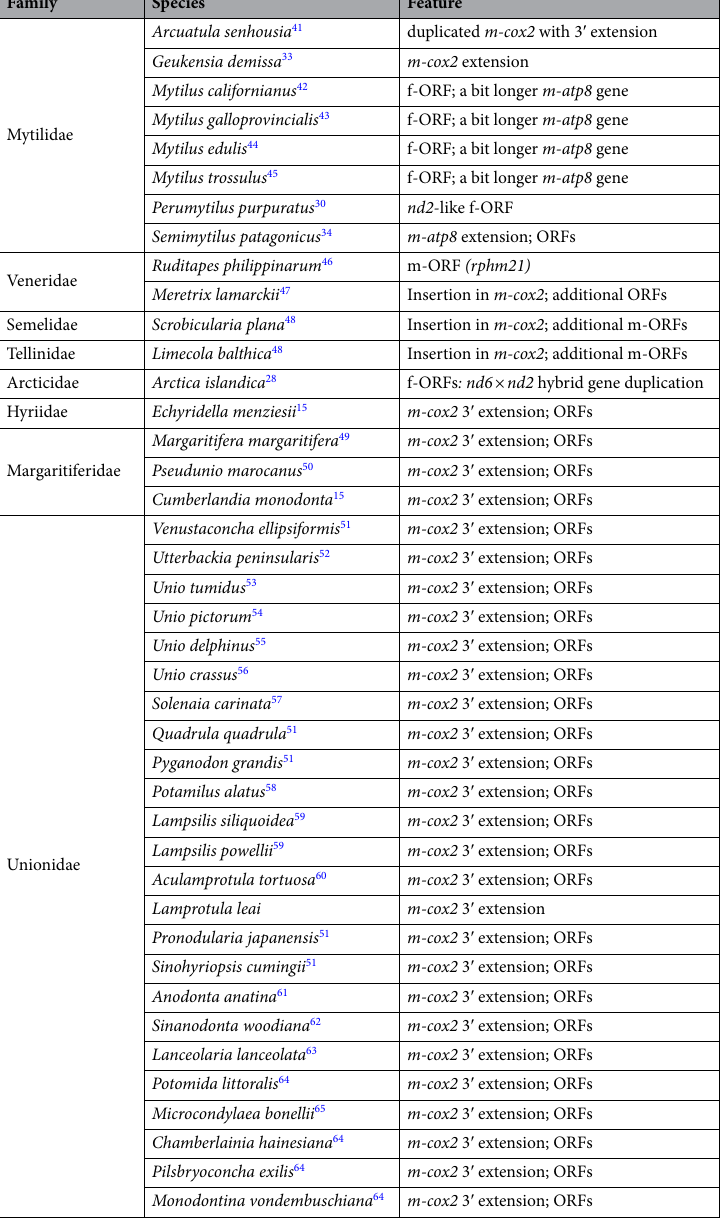
Table 2. Features correlating with doubly uniparental inheritance observed in complete pairs of mitogenomes (when both M and F are